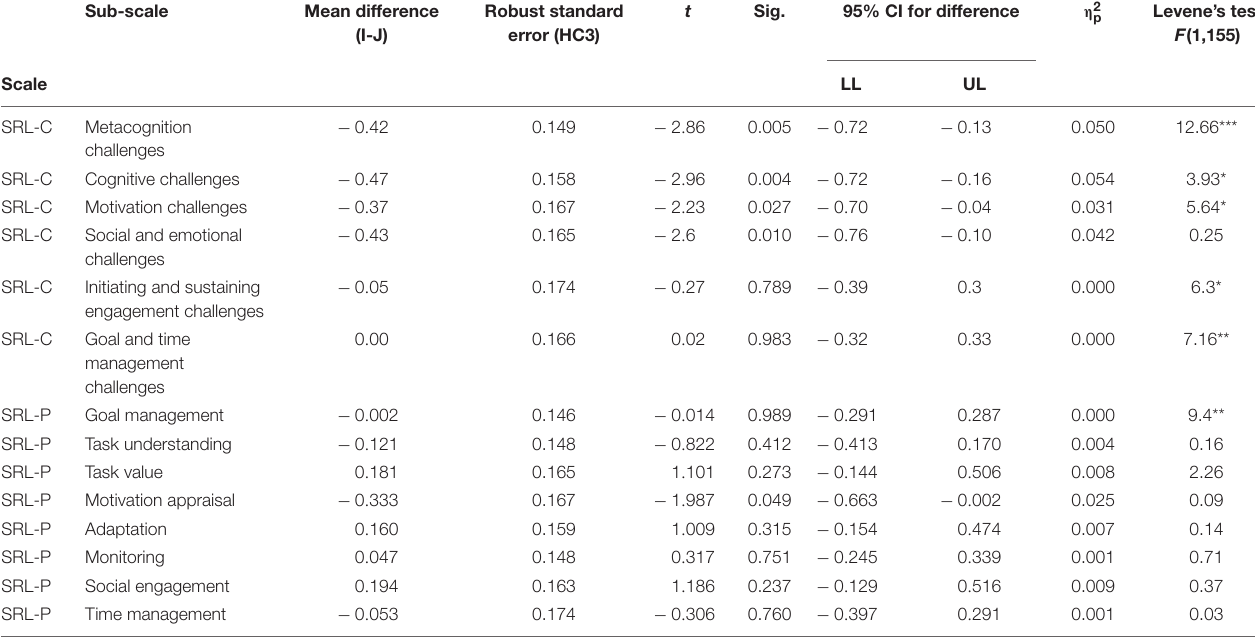
TABLE 5 | Pairwise comparisons of SRL-P and SRL-C based on estimated marginal means (SRL Training = I, Without Training = J). Sub-scale Mean difference Robust standard (I-J) error